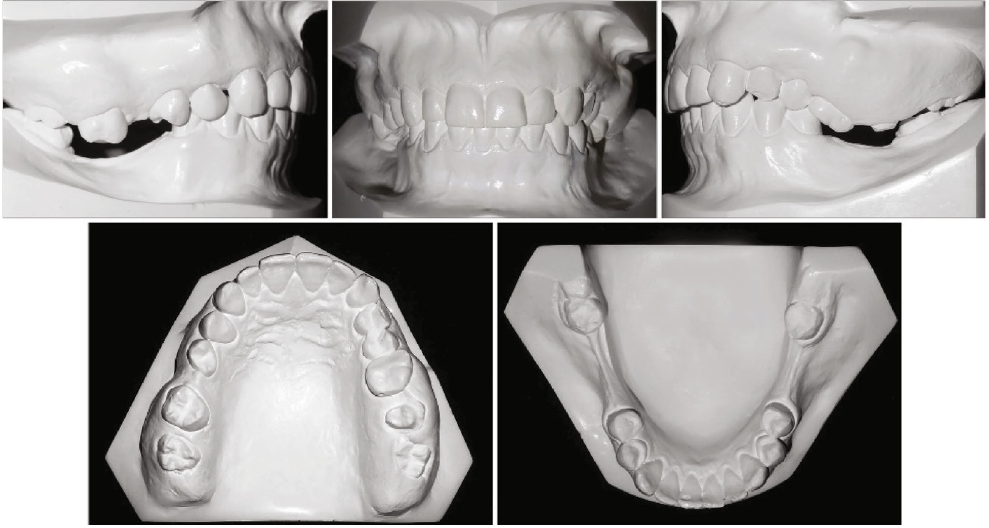
Figure 2: Pretreatment dental casts.